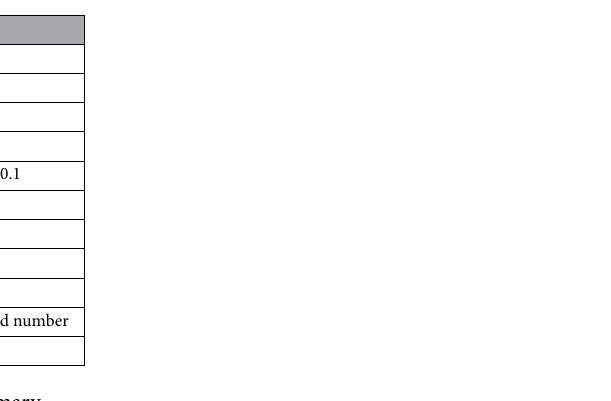
Table 2. Augmentation operations